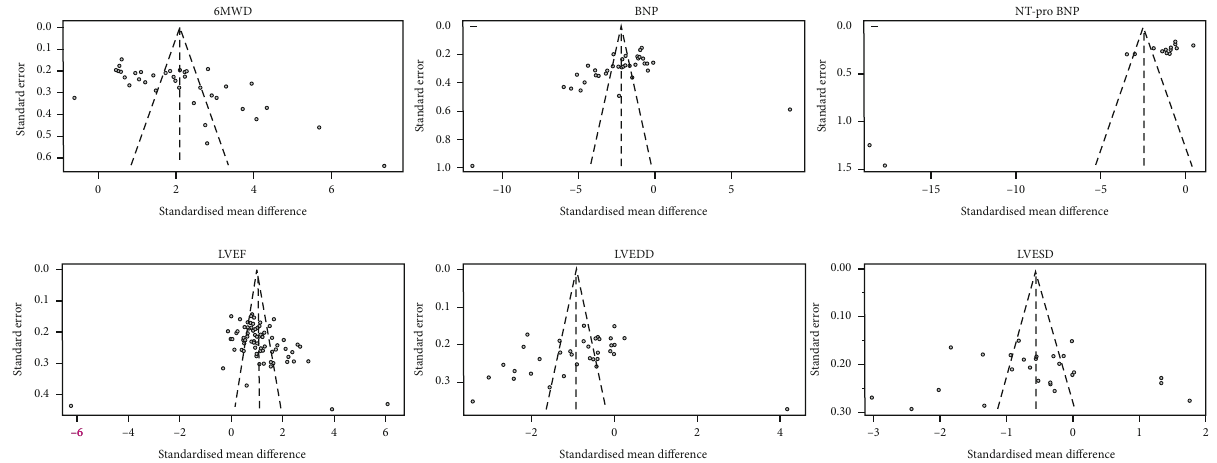
Figure 4: Funnel plots for all the